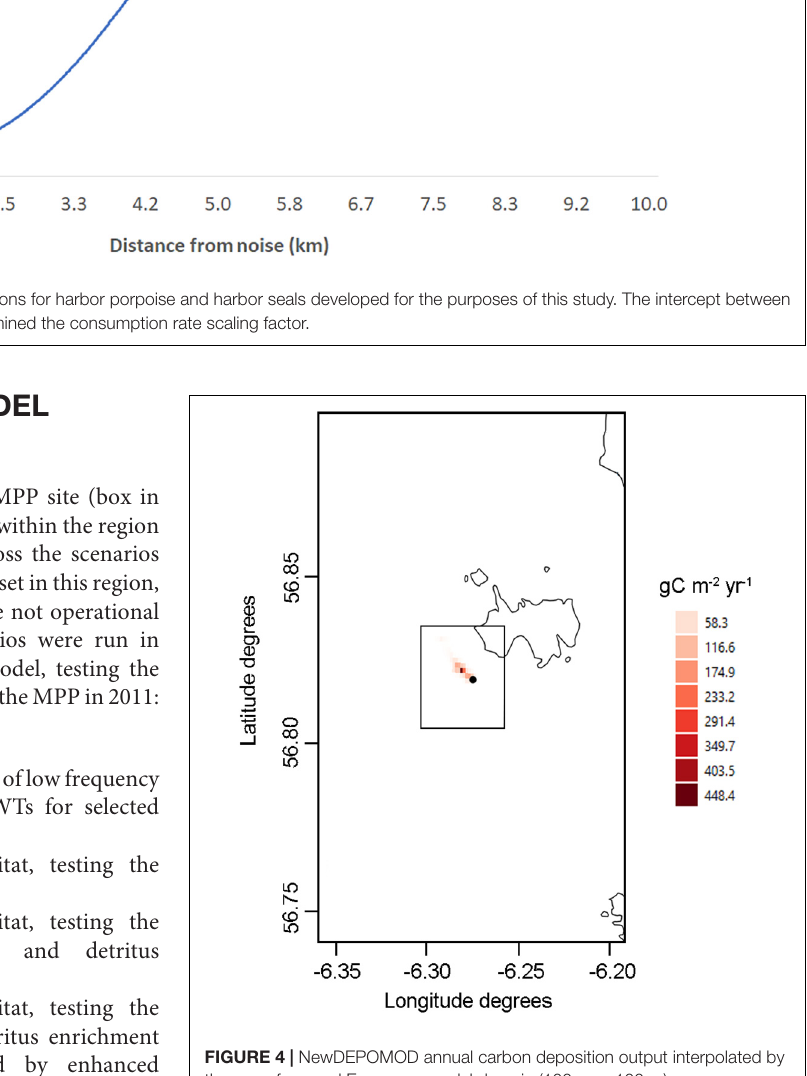
and harbor seals) with the highest proportion of preferences at the “farming” habitat ( Table 2